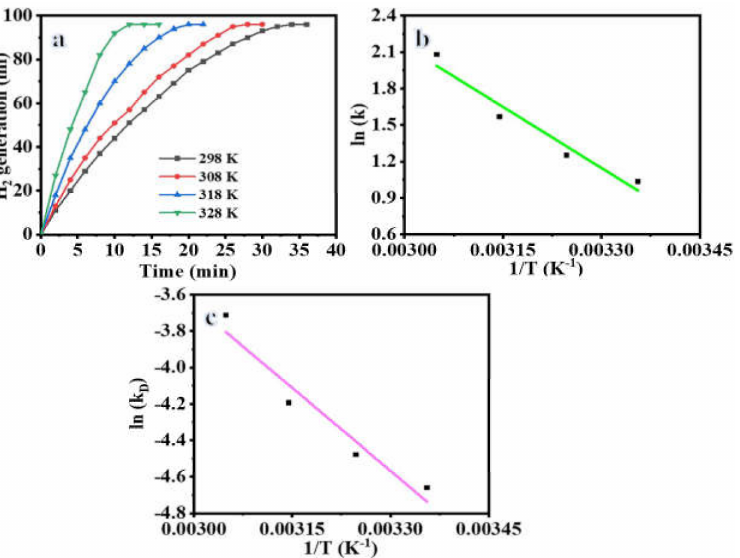
Figure 9. Influence of reaction temperature on H 2 production ( a ), the H 2 production rate constant logarithmic value vs. (1/T) ( b ), and K D (K/T) logarithmic value vs. (1/T) ( c ) at 100 mg catalyst and 1 mmol